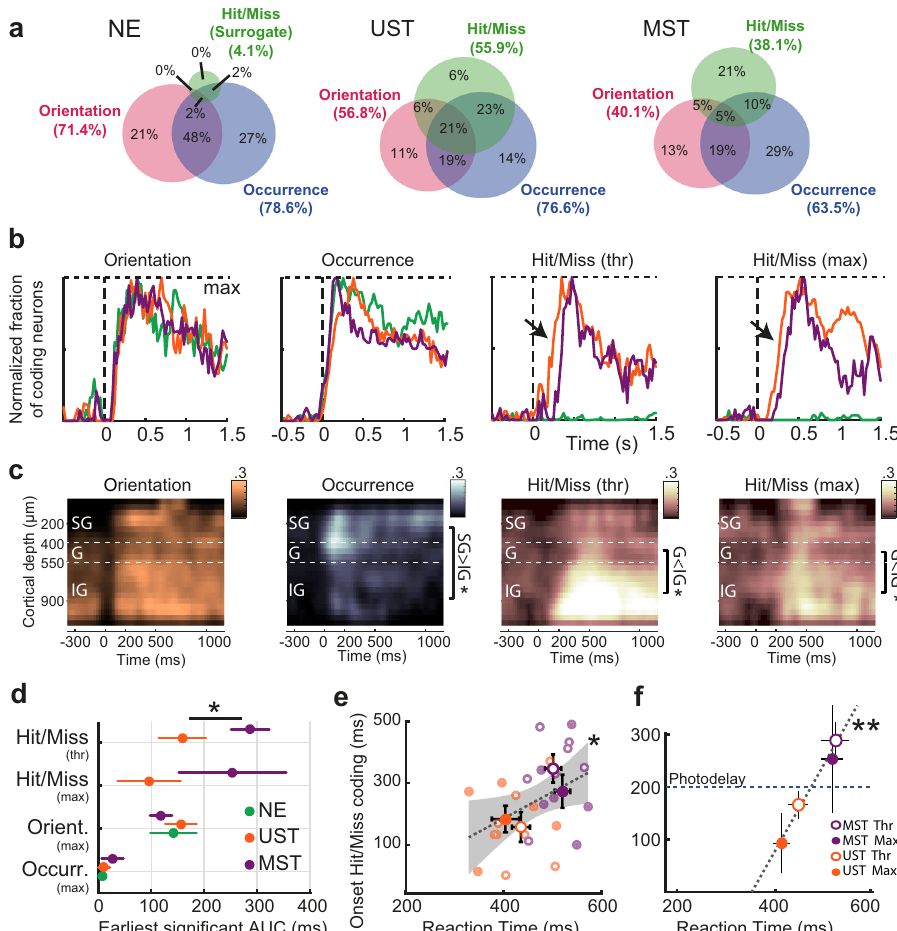
Fig. 4 The onset of late activity is delayed in MST mice. a The Venn diagrams show for each training cohort the percentage of neurons encoding orientation (grating after stimulus change), occurrence (presence of a visual change or not), or hit/miss (visual hits versus visual misses, with no lick response) as established with ROC analysis. Only maximum visual change trials were used. Shown are percentages out of all coding neurons; percentage of non-coding neurons per cohort: NE: 15.5%; UST: 13.3%, MST: 35.6%. b Fraction of neurons (summed over all recordings) coding for task-relevant variables over time. Each coding fraction is baseline-subtracted and normalized by its maximum. Visual hit/miss coding (hits vs misses) was only present in UST and MST mice (as expected) and started earlier in UST than MST mice (highlighted with black arrows). c Heatmaps of the fraction of coding neurons across time and cortical depth, with neurons binned based on their recorded depth relative to the granular layer (400 – 550 μ m from dura). Only UST and MST cohorts were included to compare sensory and hit/miss coding in the same datasets. SG = supragranular, G = granular, IG = infragranular. Occurrence coding, 0 – 200 ms, ANOVA, SG versus IG, F (1,16) = 7.21, p = 0.016. Hit/miss coding, Thr, 200 – 1000 ms, G vs IG, F (1,15) = 5.21, p = 0.037; Max, G vs IG, F (1,15) = 4.96, p = 0.042. Signi fi cance (sidebars): * p < 0.05. d Earliest increase in the fraction of signi fi cantly coding neurons. Mean ± 95% CI (bootstrap). The apparent fast onset of visual occurrence coding is likely due to temporal smoothing of fi ring rates. (Bootstrap test, two-sided, UST n = 128, MST n = 306 neurons, p = 0.012) e Reaction time correlated with the onset of hit/miss coding in population-averaged activity (ANOVA, n = 26 sessions, F (1,24) = 5.15, p = 0.03). Gray dotted line shows linear regression fi t. Each dot is one session. Error bars show mean ± SEM. f Same as e , but now for the bootstrapped average for each visually trained condition using single-neuron AUC (as in d ). Reaction time correlated with the earliest moment of signi fi cant hit/miss coding (ANOVA, F (1,2) = 102.33, p = 0.0096). Error bars show bootstrapped mean and 95% CI. Blue dotted line at 200 ms marks the time point where late photostimulation was applied (see Fig. 5d). At this point, unisensory trained mice already showed hit/miss- coding in V1, while multisensory trained mice did not. and the detection of a different stimulus dimension (contrast Pursuing the comparison with task A, laminar recordings in instead of orientation change). V1 revealed similar neural dynamics, with a marked early We controlled stimulus salience by varying visual contrast and stimulus-driven component visible in contralateral visual trials, whisker de fl ection amplitude and fi tted the behavioral data with a and late activity in both contra- and ipsilateral visual hits (Fig. 6c, psychometric model (Fig. 6b; see Methods). The visual detection Supplementary Fig. 8f; see also Supplementary Fig. 8g for lick- threshold and task performance at maximum saliency were similar aligned neuronal activity). This late V1 activity was also present for both cohorts (UST and MST, Supplementary Fig. 8a, b). As in in tactile-only hits — so without visual stimuli — although only for Task A, we found that visual reaction time (RT) decreased for MST mice (Supplementary Fig. 8h). We optogenetically silenced higher stimulus saliencies (Supplementary Fig. 8c). In contrast unilateral V1 either from stimulus onset (early silencing) or after with task A, however, RTs were similar between tactile and visual a delay that separated the late from the early wave of activity trials. (240 ms, late silencing; Fig. 6c). Early silencing of unilateral V1 NATURE COMMUNICATIONS| (2022) 13:2864